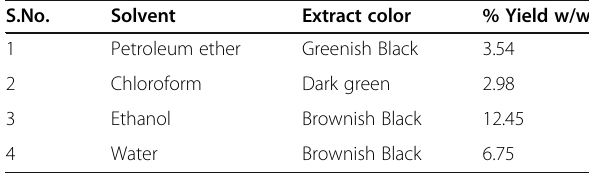
Table 2 Percentage yield of PH